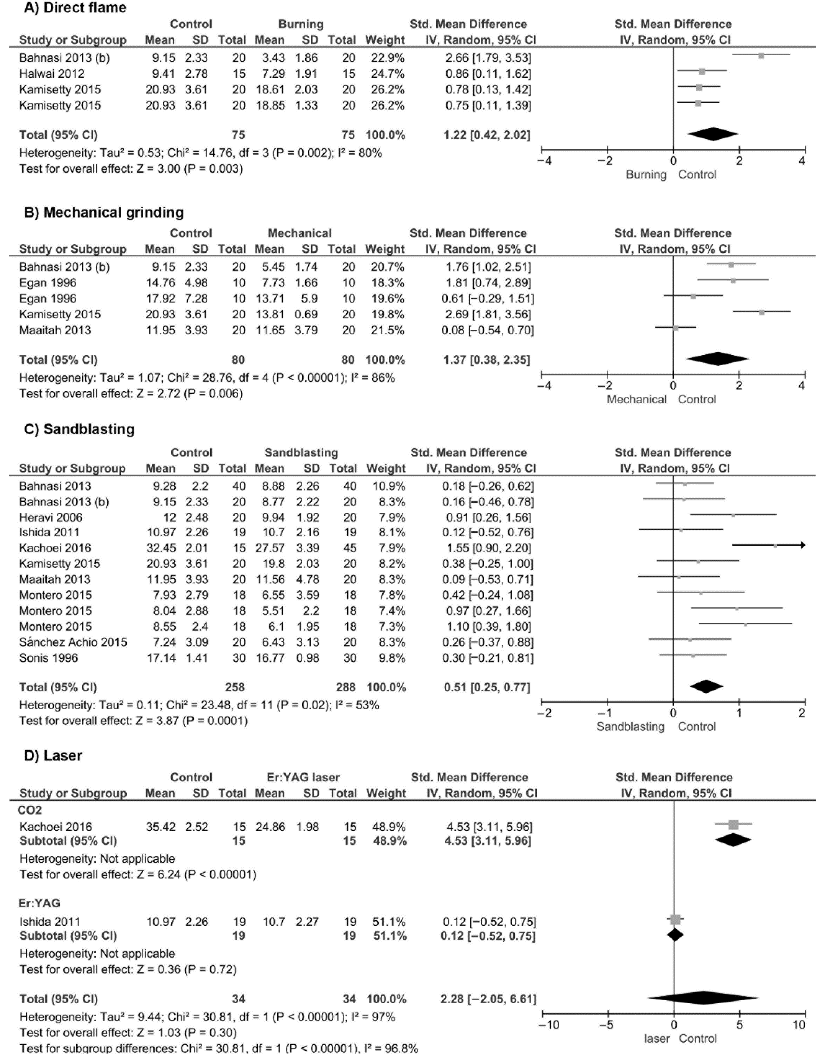
Figure 2. Results of the meta-analysis of bond strength of debonded orthodontics brackets after residual adhesive removal using; ( A ): Direct flame; ( B ) Mechanical grinding; ( C ): Sandblasting; and ( D ): Laser. Table 3. Qualitative synthesis (risk of bias assessment).